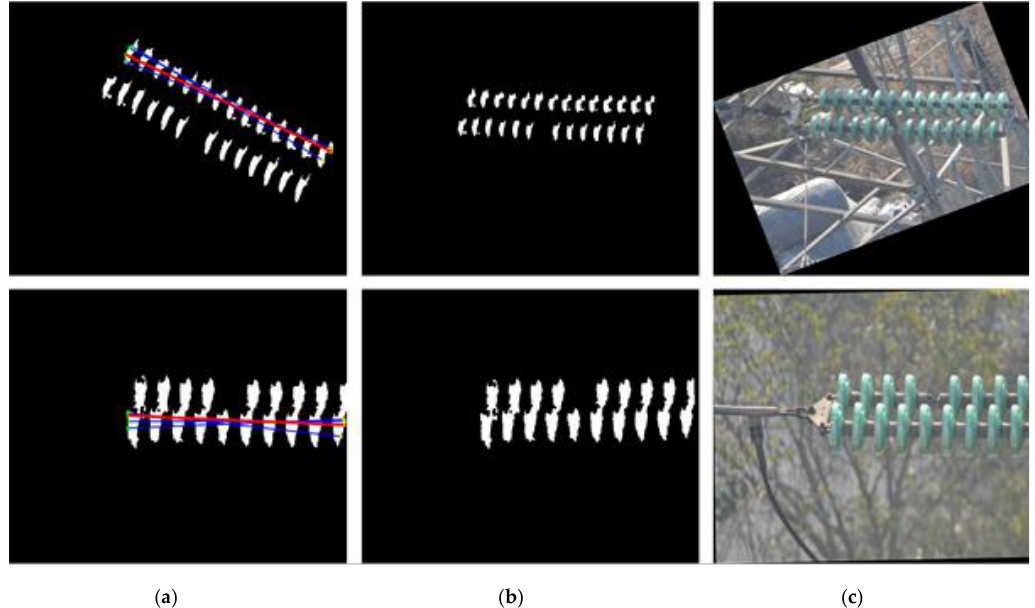
Figure 4. Tilt correction: ( a ) Hough transformation detection of lines; ( b ) Tilt correction; ( c ) Correction of original image.